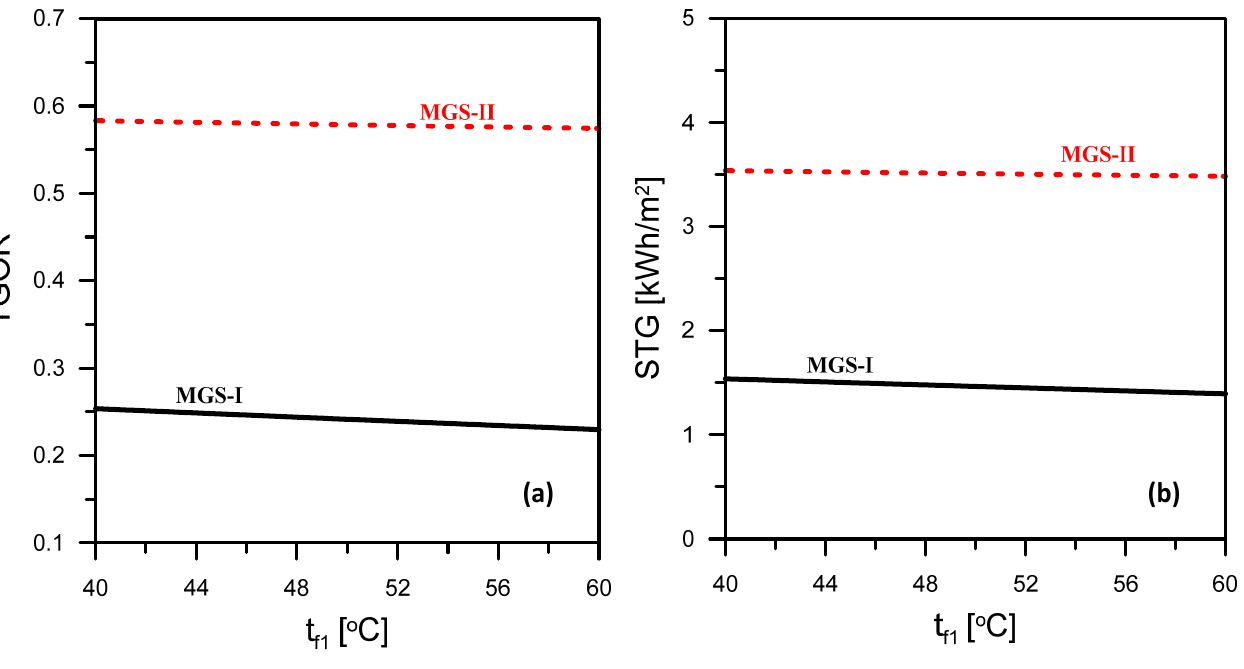
Figure 6. Impact of ORC condensation temperature on proposed systems’ performance: ( a ) TGOR; ( b ) STG.